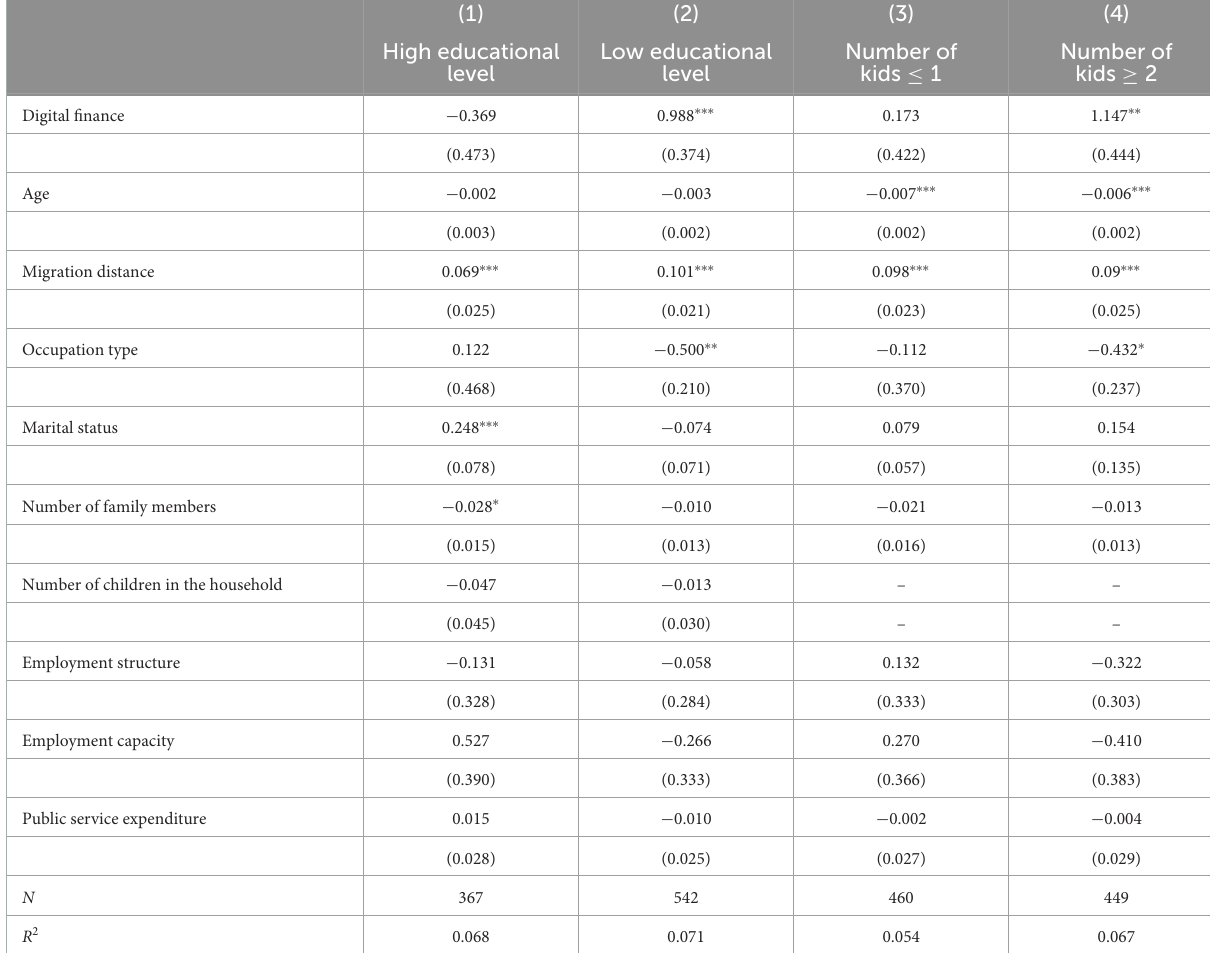
TABLE 11 Regression results of heterogeneity